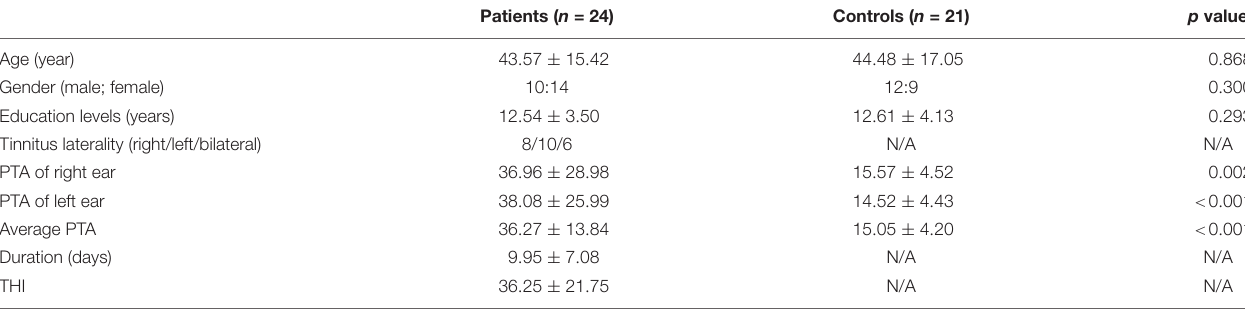
TABLE 2 | Demographic and clinical characteristics of sudden deafness with tinnitus patients and healthy controls.